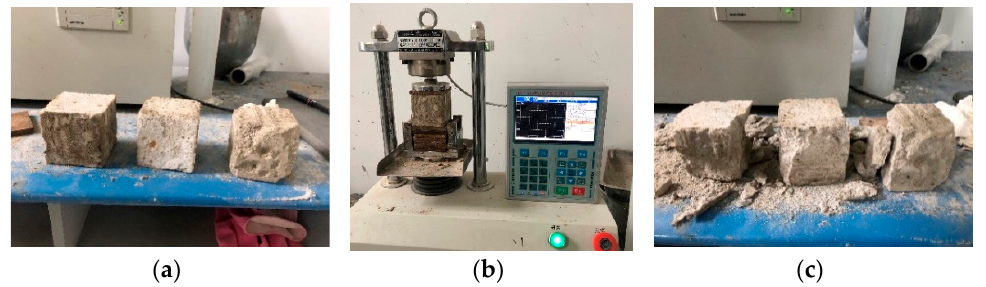
Figure 4. Compressive strength test of masonry mortar. ( a ) Demolding form; ( b ) loading; ( c ) de- struction form.